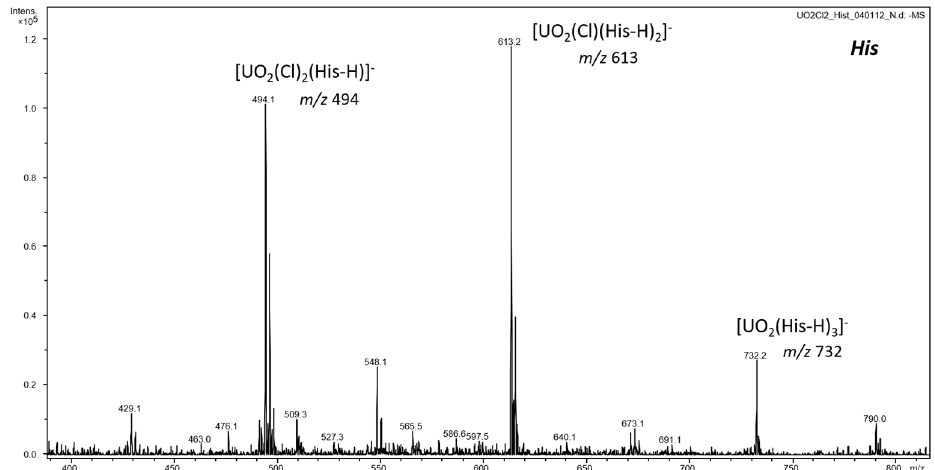
Figure 2. ESI-MS of a uranyl chloride + histidine solution (1:4) in negative ion mode. Uranyl complexes containing cystine (Cis) were identified in spectra obtained from UO 2 Cl 2 +Cys solutions, as cystine easily forms through condensation of two cysteine molecules that covalently link via a disulfide bond (see Figure S6; see also Scheme S2 that shows the structure of